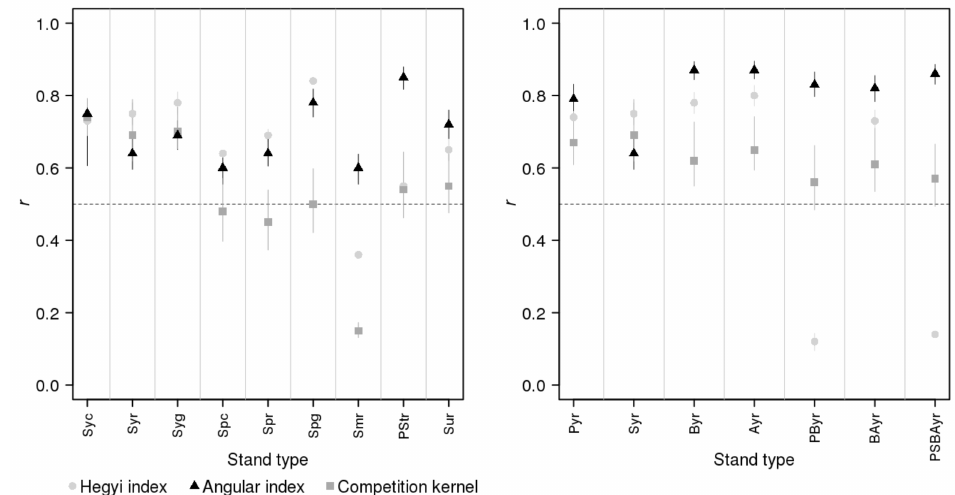
Figure 2. Pearson linear correlation ( r ) between outputs from three competition indices ( CI i ) and outputs from mechanistic spatially explicit models ( RES i ). Dashed horizontal line denotes r = 0.5. Stand type codes are the following: uppercase letters denote species (P—pine, S—spruce, B—birch,